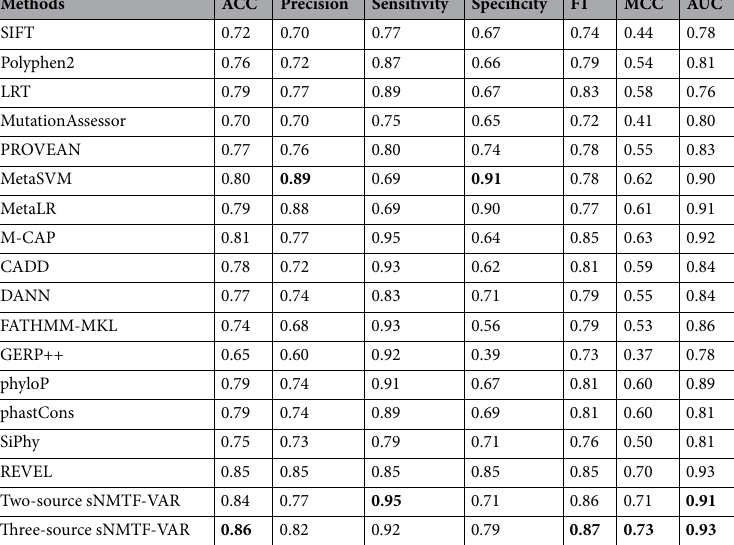
Table 3. Performance evaluation based on benchmark test data I: ACC accuracy, MCC Matthews correlation coefficient, and AUC area under curve.